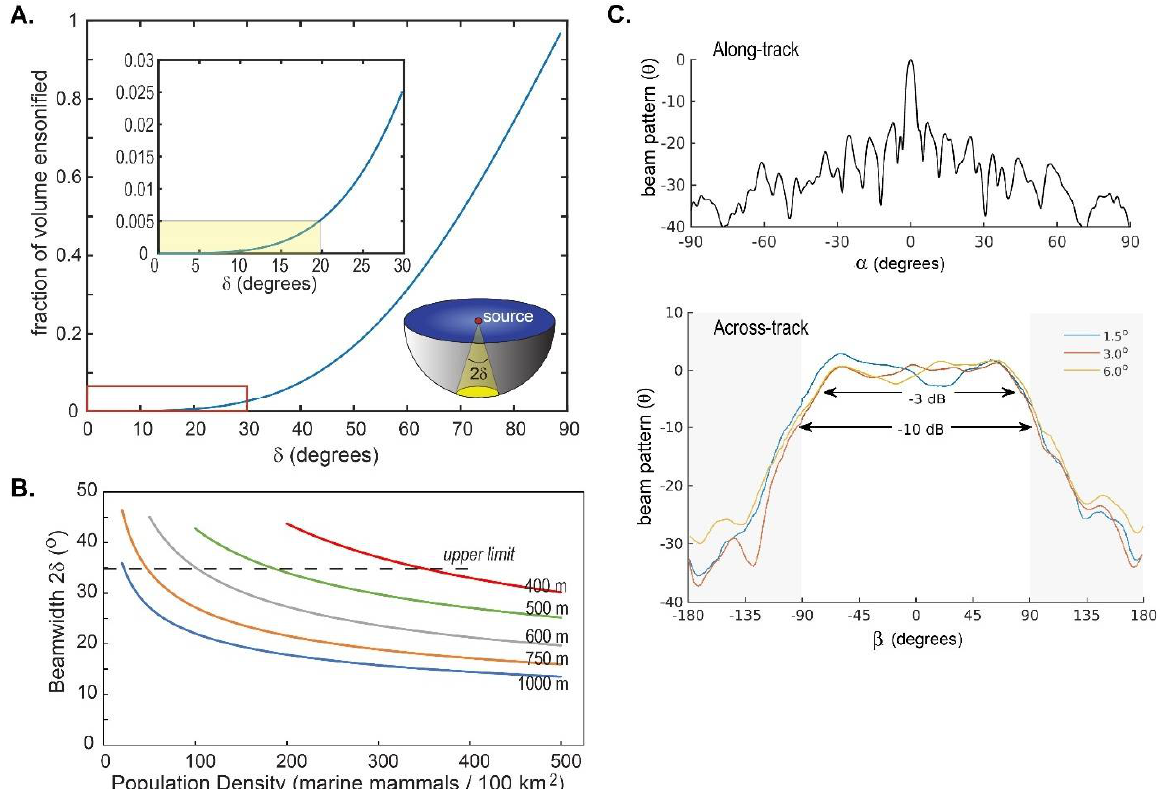
Figure 9. ( A ) The fraction of the volume of a hemisphere ensonified by a source located at the hemisphere’s center and emitting an isotropic (conical) beam of width 2δ, assuming no beam spreading. Inset shows an enlargement of the area in the red box. Note that ~0.5% of the hemisphere’s volume is ensonified for δ up to ~20°. ( B ) Beamwidth limit 2δ for various marine mammal densities and water depths, with p = 0.01. Details in the text and Figure S8. ( C ) shows the beam patterns measured by [8] as a function of angle a function of angle for a Reson 7111 MBES system (100 kHz; SPL of 233 dB re 1 μPa @ 1 m) held vertically in the water column and transmitting at 1.5 ms pulse length. The top panel shows the along-track pattern (Figure 2) for 3° beam. The bottom panel is the across-track patterns for 1.5°, 3°, and 6° beamwidths. For a MBES mounted on a ship’s hull, instead of vertically, only the angles between −90° and 90° (white area) are relevant.